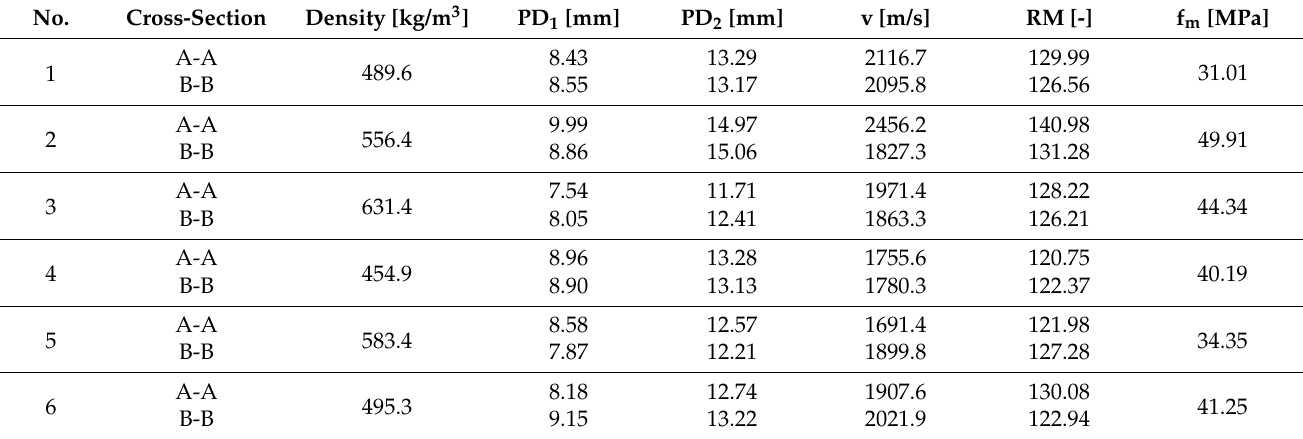
Table 4. Average results of destructive, non-destructive, and semi-destructive tests.